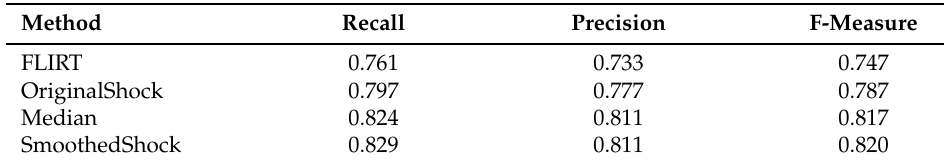
Table 2. Performance of fMRI data classifier with different pre-processing filters.